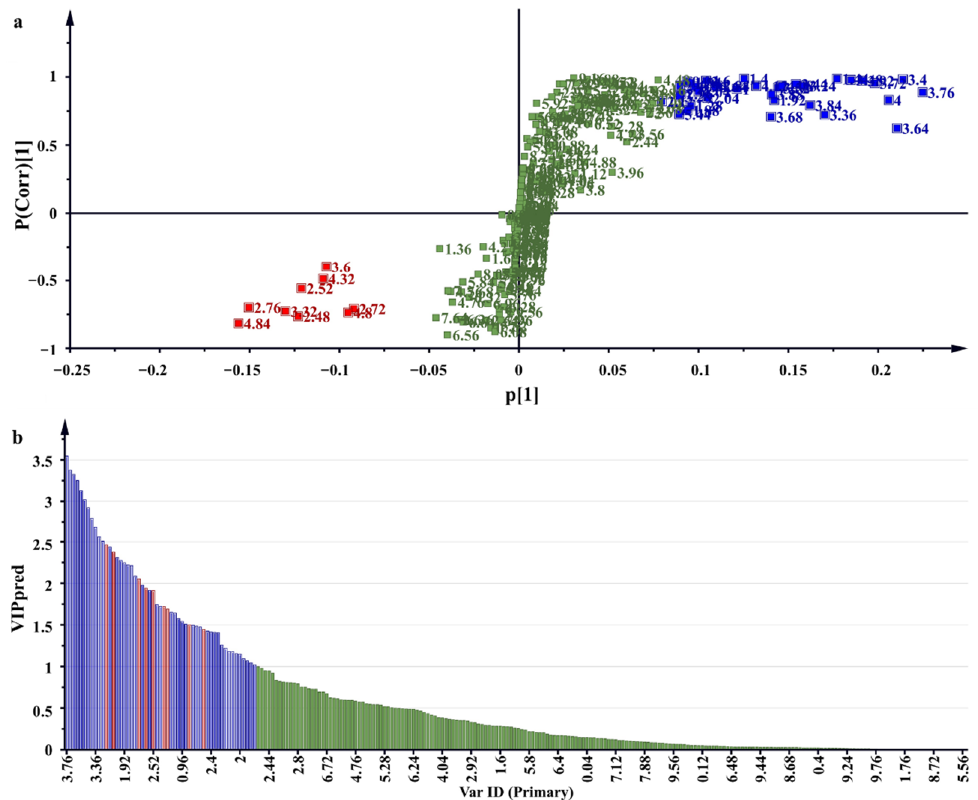
Figure 4. A representative OPLS-DA-derived S-plot ( a ) and VIP score plot ( b ) showing 1 H NMR regions that contributed to clustering and separation of samples. Cluster ( a ) 1 H NMR regions with high DPPH scavenging activity in red and cluster ( b ) 1 H NMR regions associated with low DPPH scavenging activity in blue.